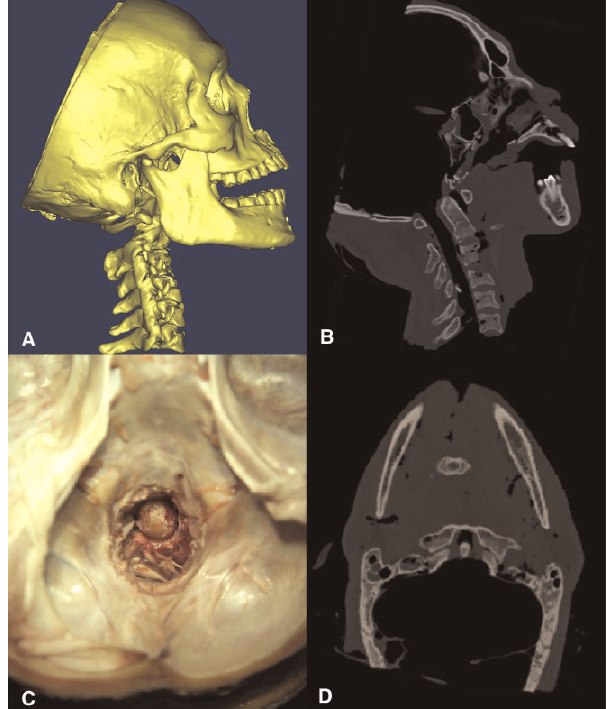
Figure 2 - A diagram showing the creation of simulative atlantoaxial dislocation. A Lateral view of the cadaver (CT reconstruction) after the creation of simulative dislocation; B Lateral-viewed CT scan; C Top view from the transcranial approach; D Axial-viewed